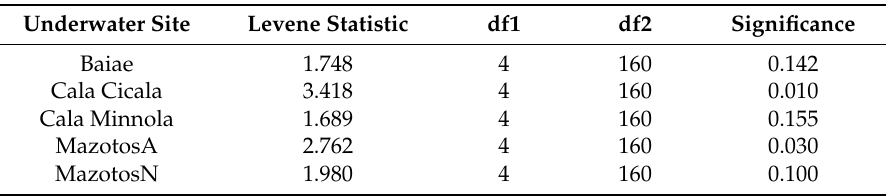
Table 8. Test of homogeneity of variances.